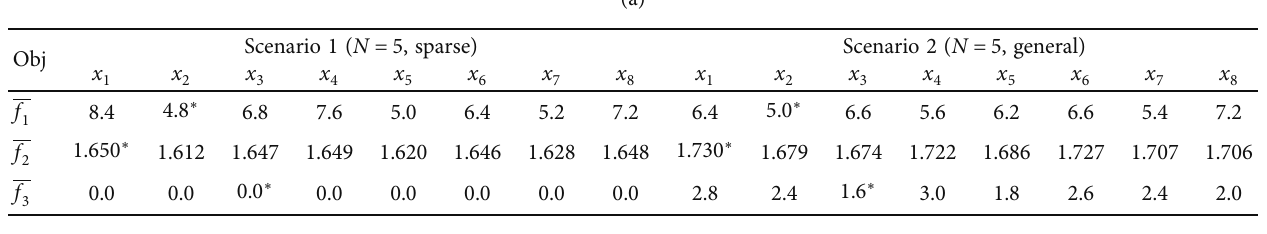
Table 5: Some results to show the trade-o ff among di ff erent objectives.